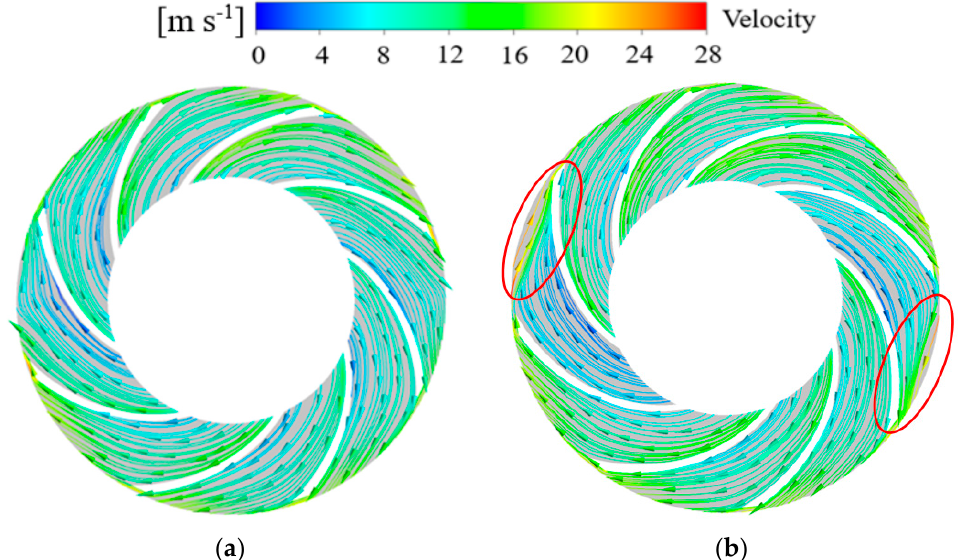
Figure 10. Comparison of the first-stage impeller velocity distribution before ( a ) and after ( b ) opti- mization.